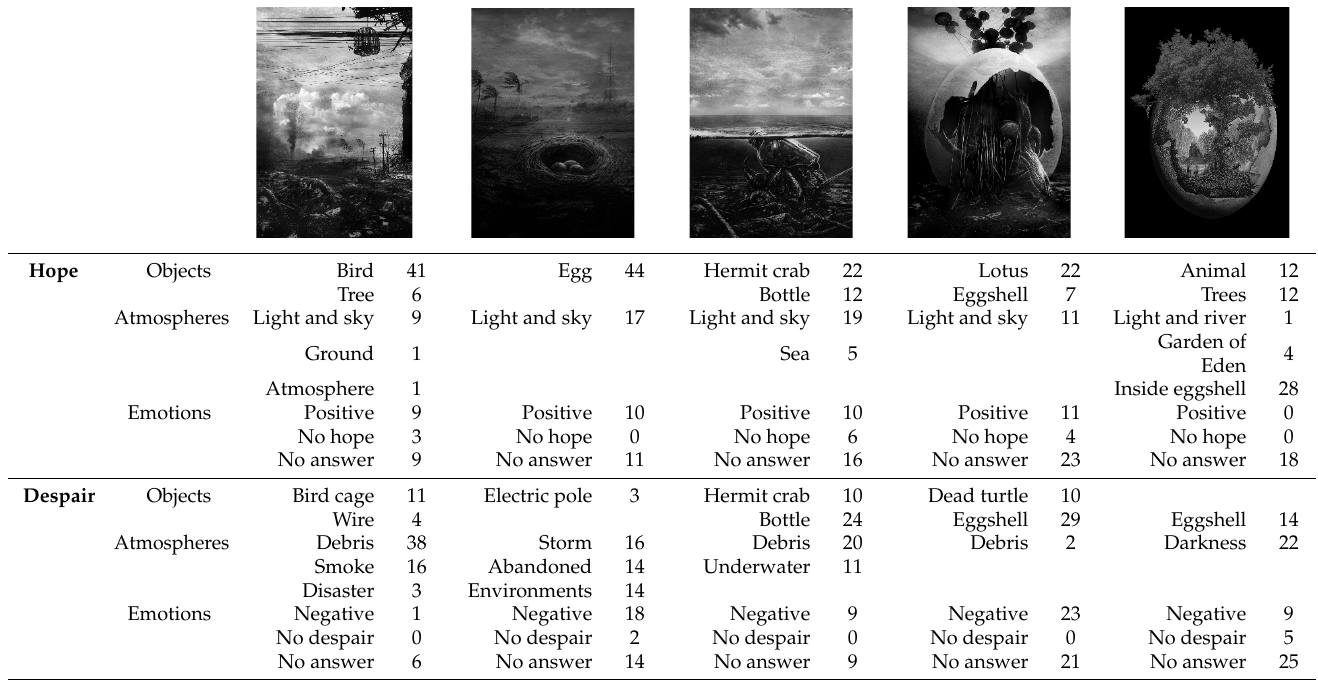
Table 8. Amount of comments on black-and-white images expressing hope and